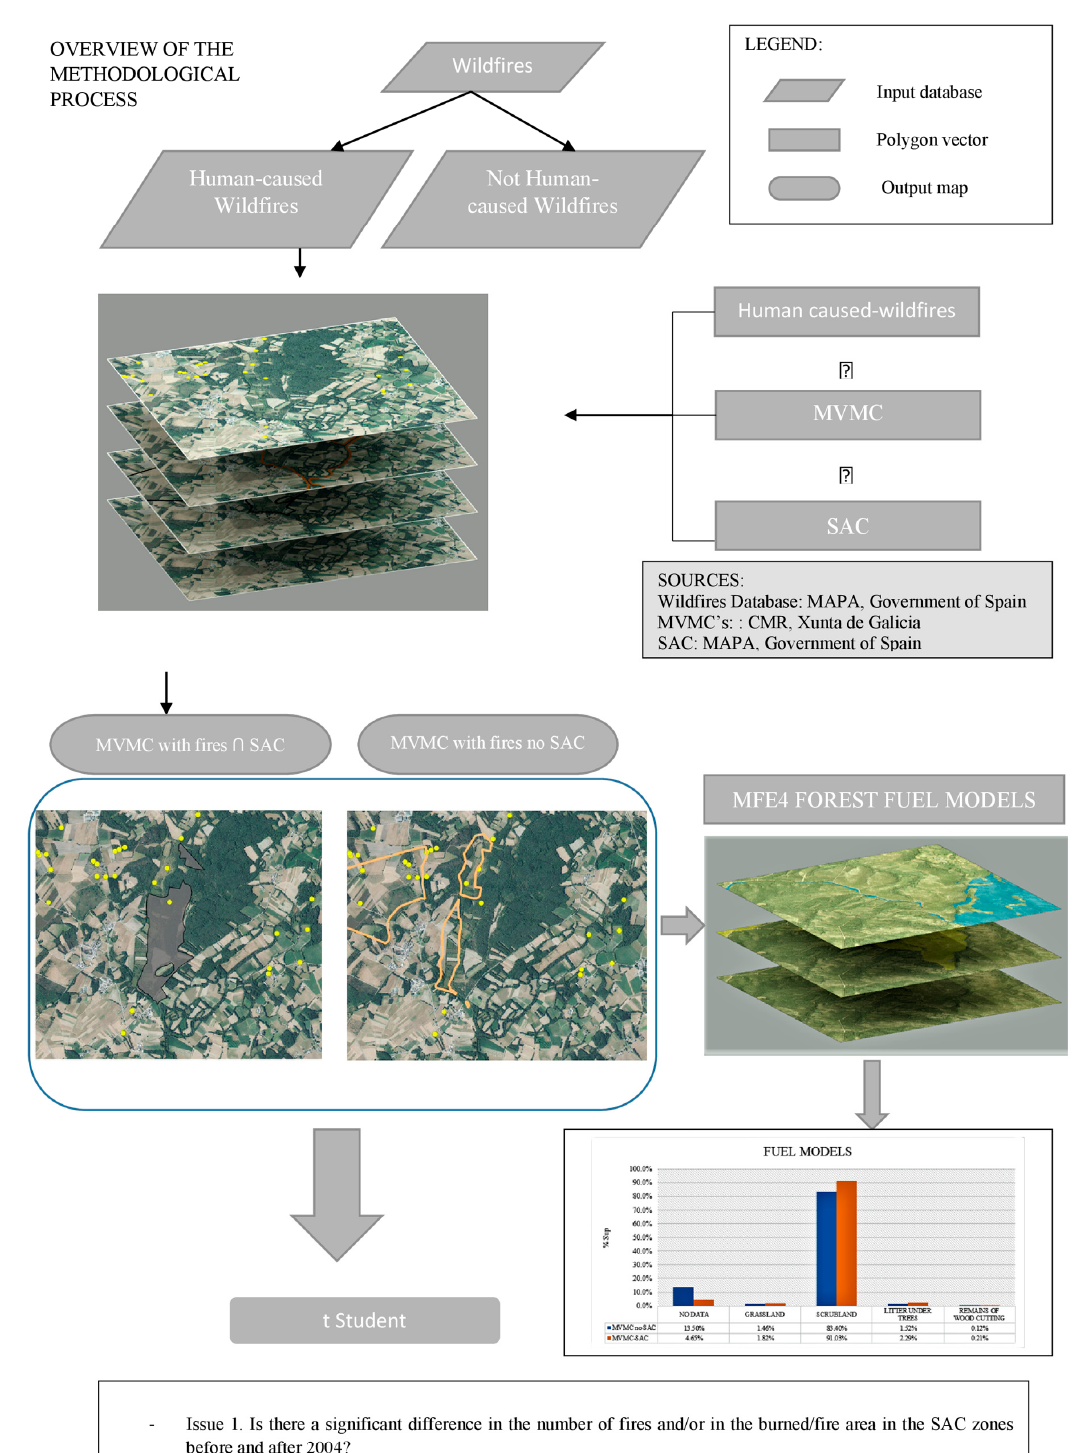
Figure 4. Overview of the methodological process. The superposition of several layers of informa- tion (forest fires, MVMC and SAC) allowed us to determine whether there were differences in the occurrence of forest fires in each of the different territorial units